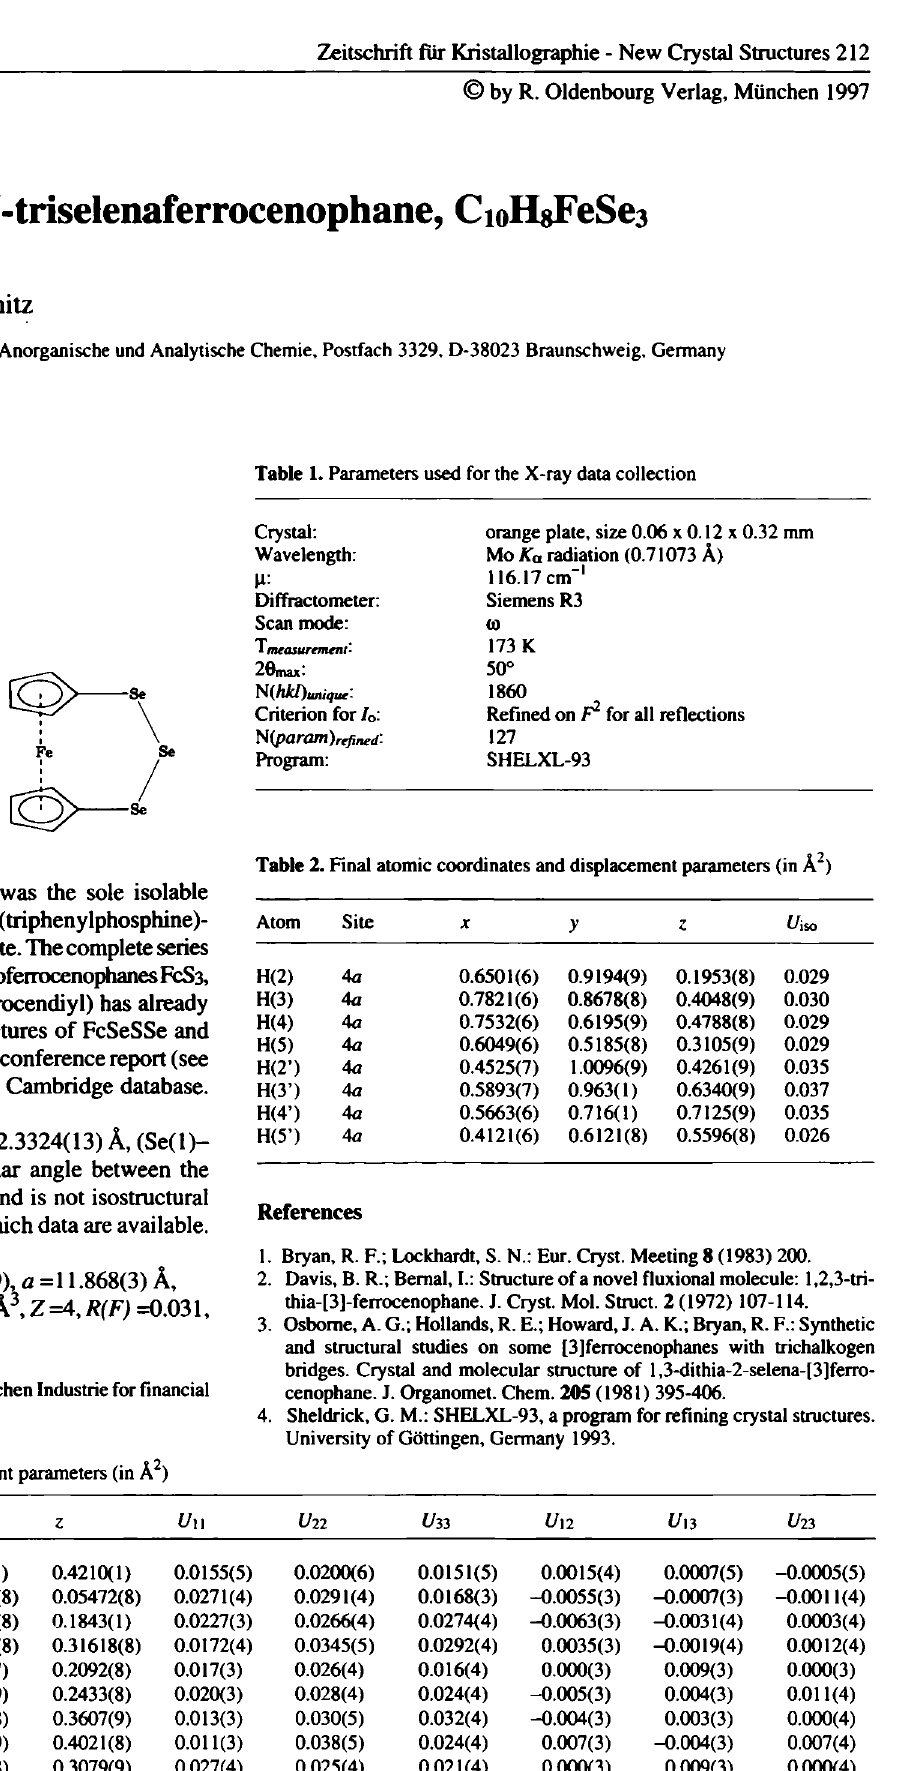
Table 1. Parameters used for the X-ray data collection